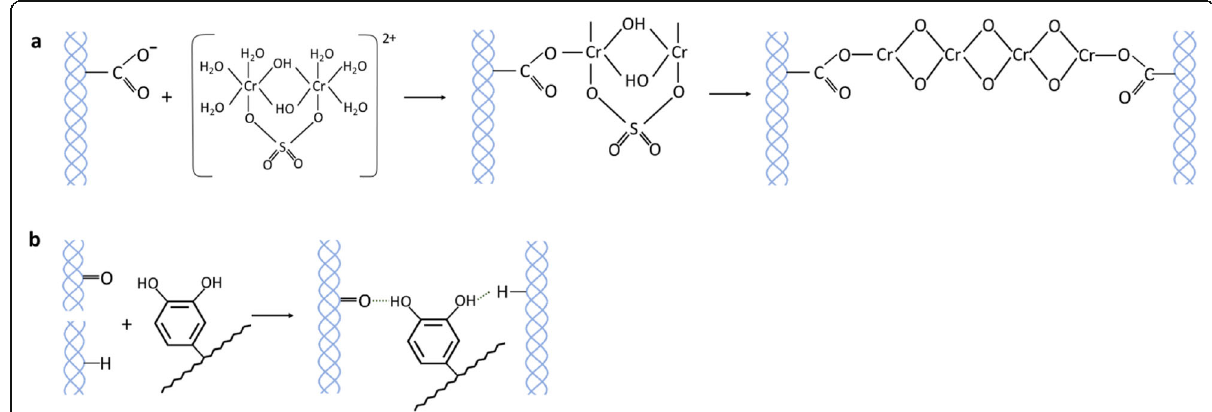
Scheme 3 Schematic illustration showing the reaction of chromium (a) [197] and plant polyphenols (b) with collagen respectively